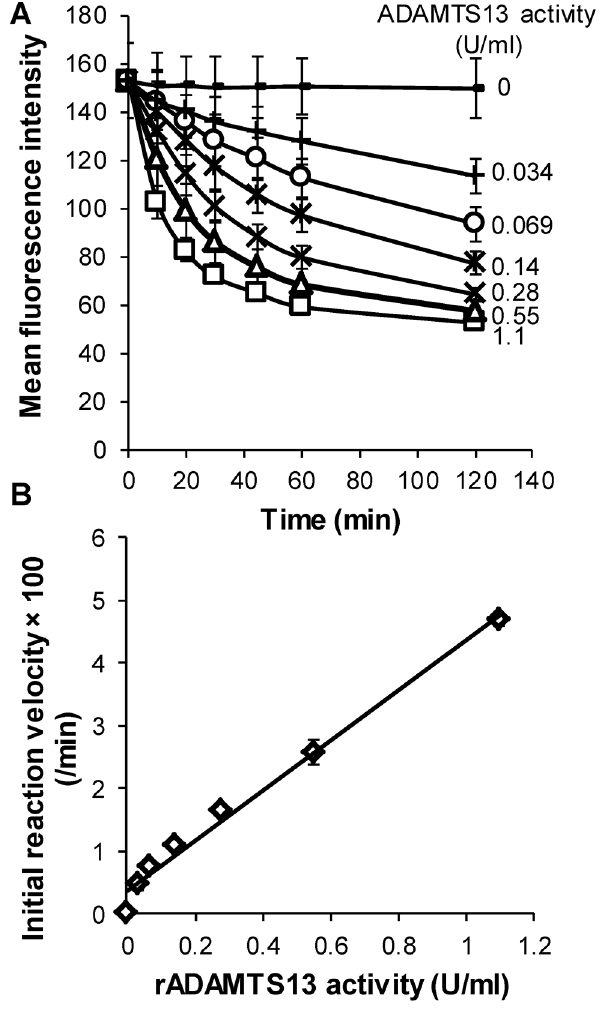
Fig 3. Dose-dependent proteolysis by rADAMTS13. A. Streptavidin coated microspheres bearing A2-77p- short were incubated with varying concentrations of rADAMTS13. Proteolysis was detected within 30min. even when protease concentration was 3.4% of normal plasma levels. B. Rate of proteolysis varied linearly with rADAMTS13 activity (R 2 =